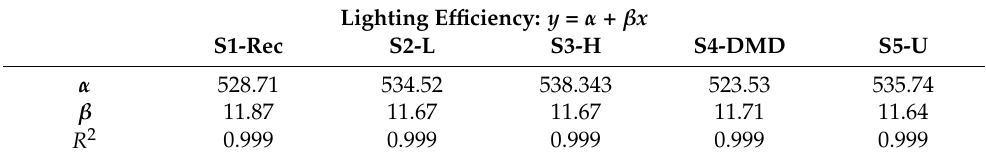
Table 11. Summary of lighting efficiency regression